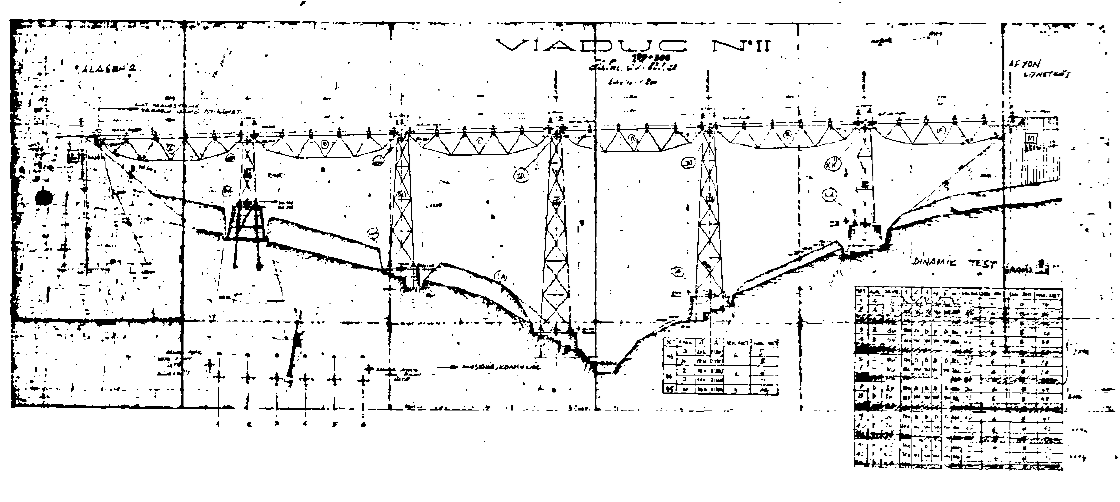
Figure 1. Bridge project plan from 1923.